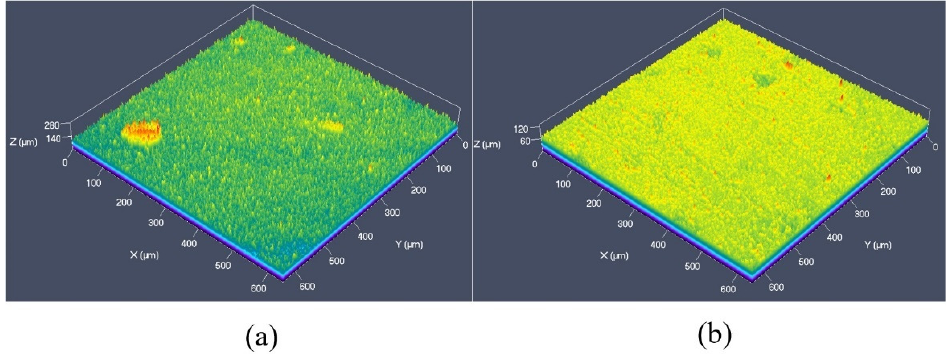
Figure 4. LSCM images: ( a ) Mg coating; ( b )PEEK substrate.